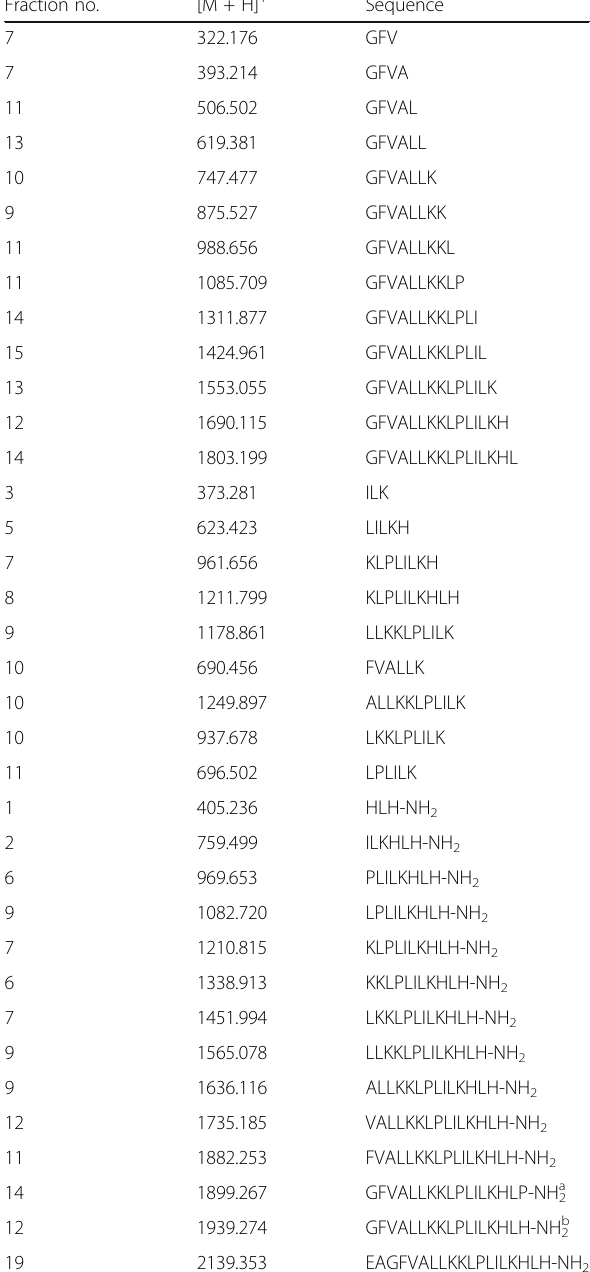
Table 5 Peptides without amidated C-terminus Fraction